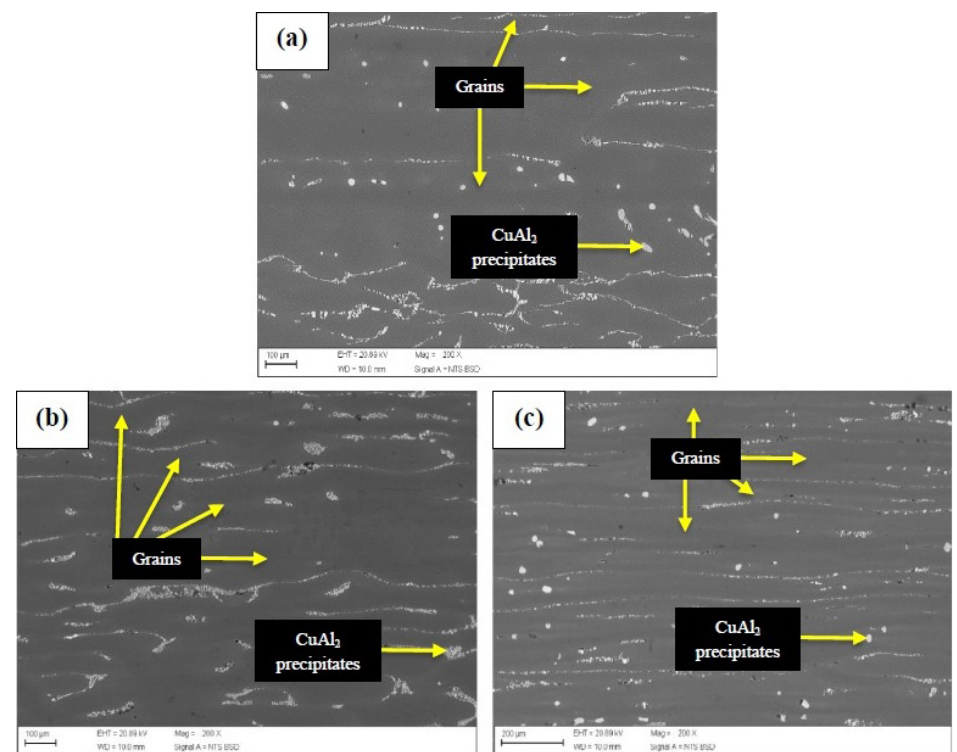
Figure 4. Microstructure of the Al4.5wt%Cu alloy after unidirectional solidification and RA of (a) 54% (b) 76% (c)